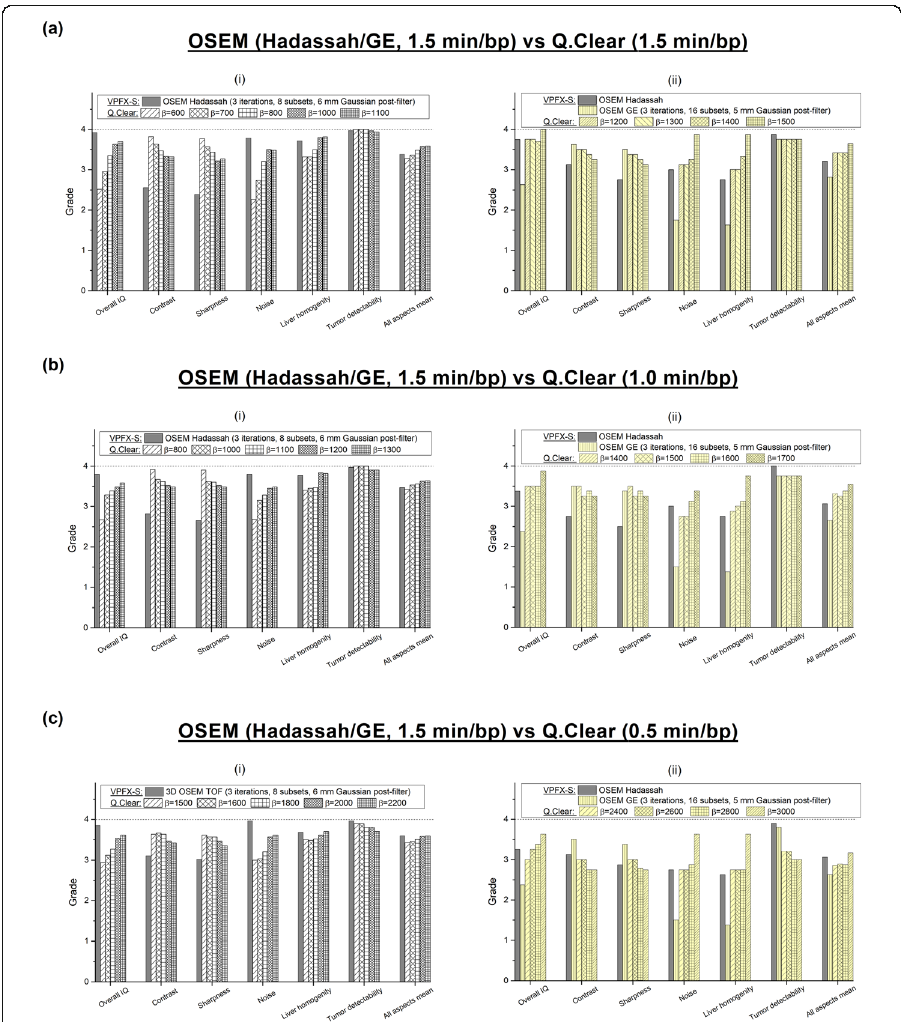
Fig. 5 Mean of visual assessment (overall image quality, contrast, sharpness, noise level, liver homogeneity, tumor detectability and mean of all rated aspects) for Q.Clear reconstructions with different β values and a 1.5 min/bp, b 1.0 min/bp and c 0.5 min/bp and Hadassah and GE OSEM recontructions (1.5 min/bp) following a 4-point scale (1, very poor/nondiagnostic; 2, poor; 3, good and 4, very good). The first analysis (i) included 30 patients against 8 patients for the addiotnal one